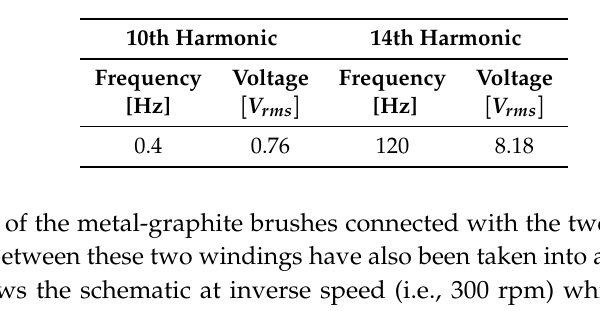
Table 7. Synchronous speed at inverse rotation measurements.